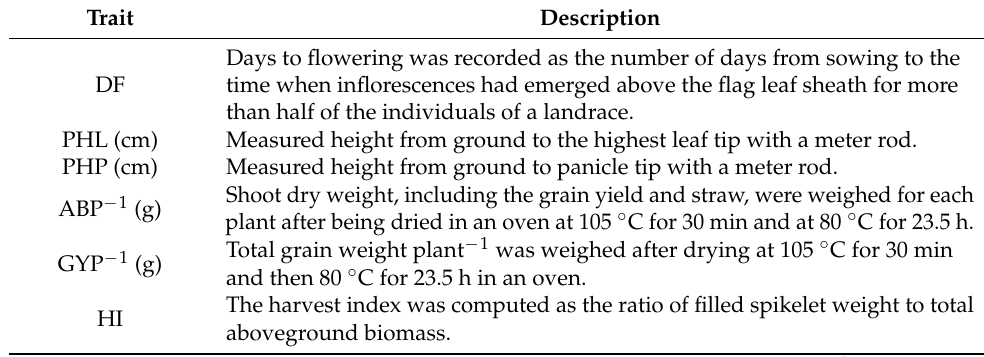
Table 2. Selected traits of study, their abbreviations and measurement